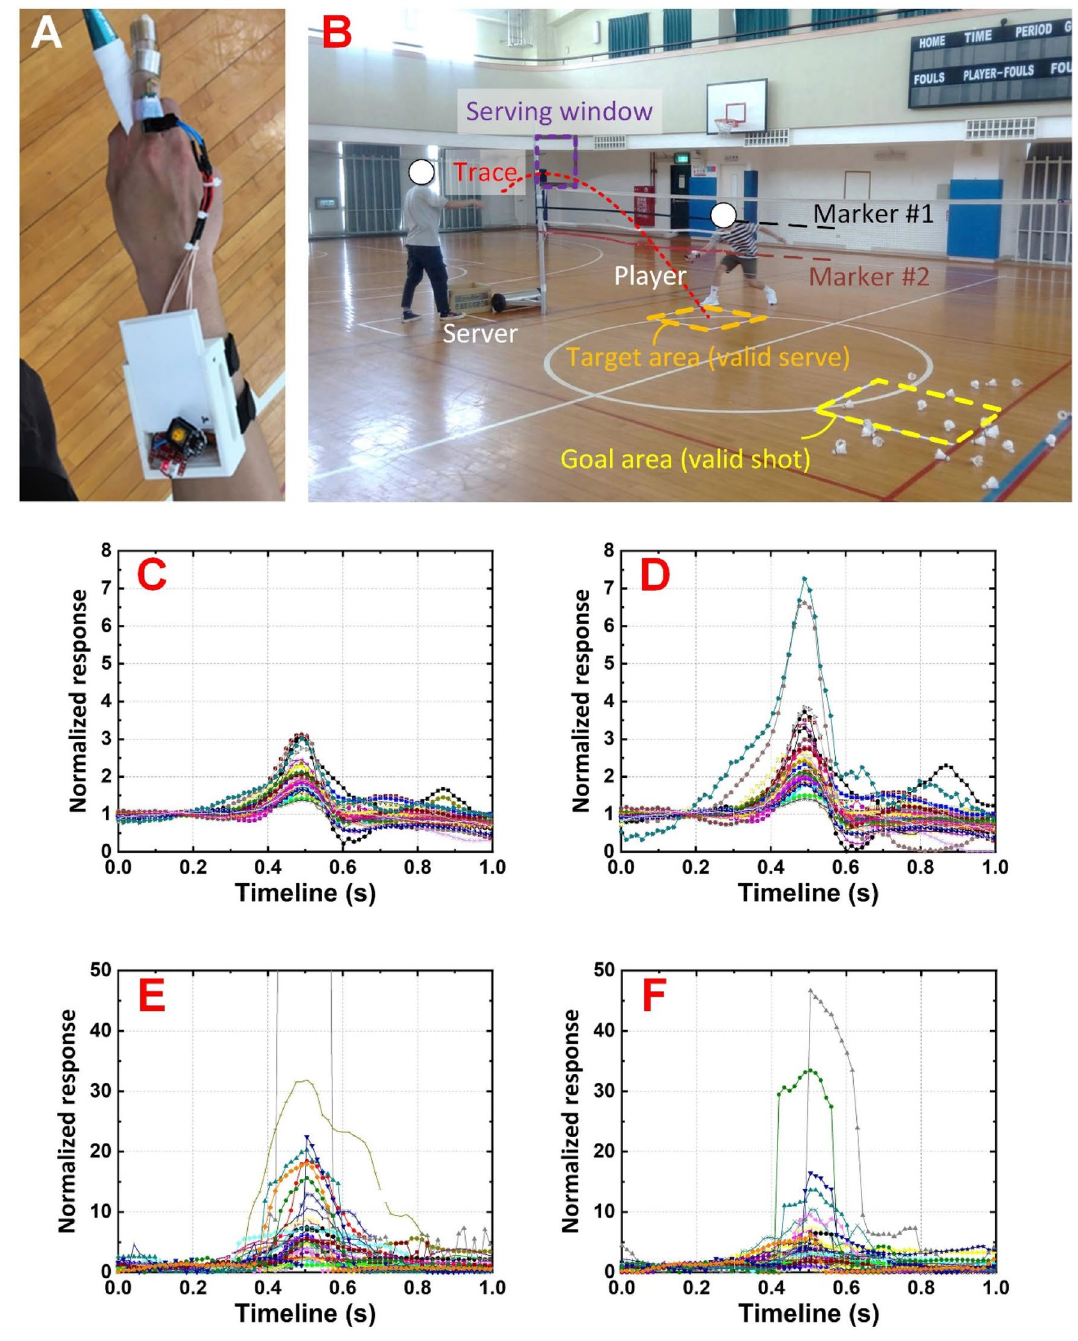
Figure 3. Field test with ( A ) the proposed and fabricated wearable system, in which an additional fingerstall was attached to fix the adaptor and a cover was attached to the transmission port, and ( B ) the court layout, in which target area, goal area, and two markers on the net were indicated for the valid serves and shots. Cumulative 67 normalized capacitive responses on the ( C ) first and ( D ) second segment of the index finger of the professional player. Cumulative 39 normalized capacitive responses on the ( E ) first and ( F ) second segment of the index finger of the amateur player. Note that not only the patterns of the capacitive responses were different but also their absolute values show noticeable difference between the professional and amateur players in ( C )–( F ), implying the performance and stability of the